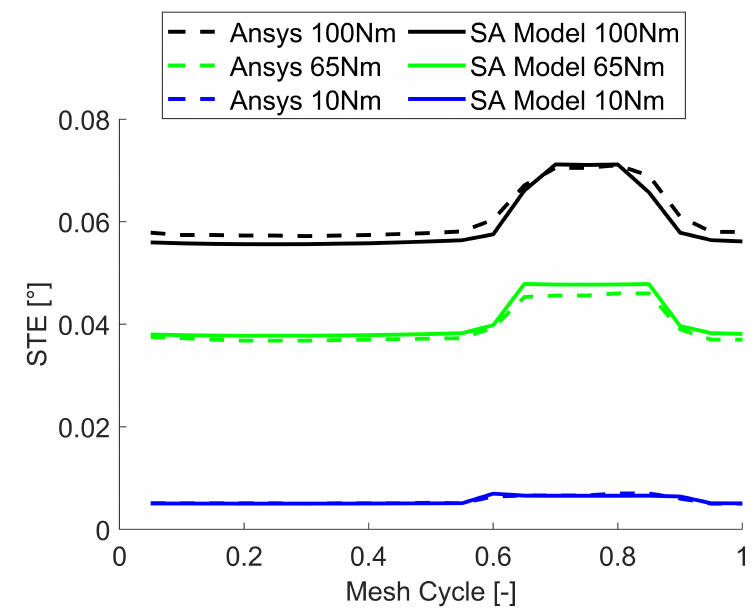
Figure 12. Comparison of the STE obtained from the SA model and Ansys.